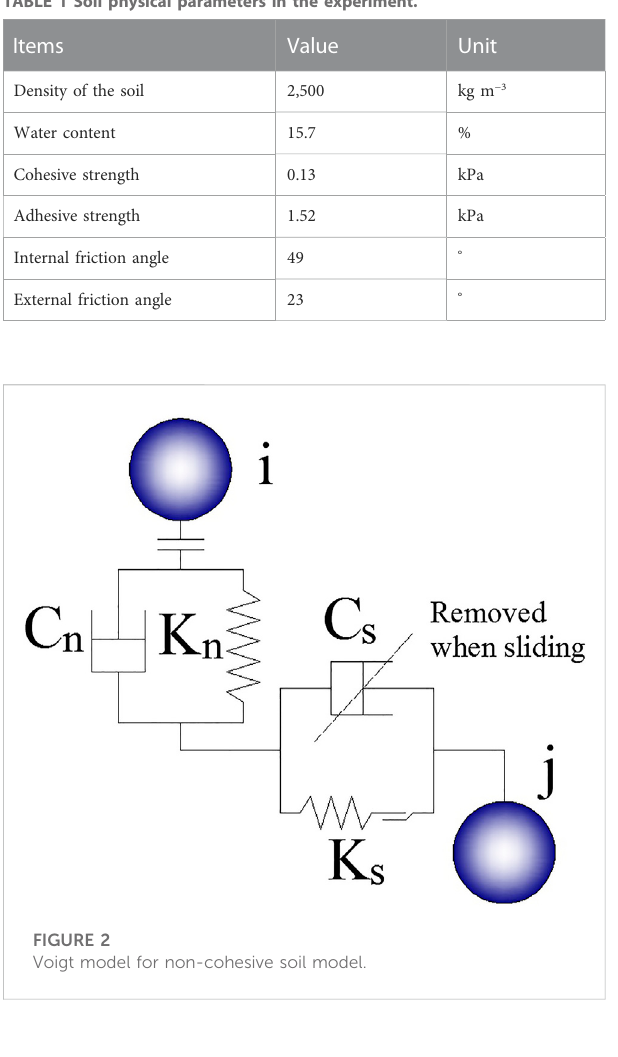
TABLE 1 Soil physical parameters in the experiment.